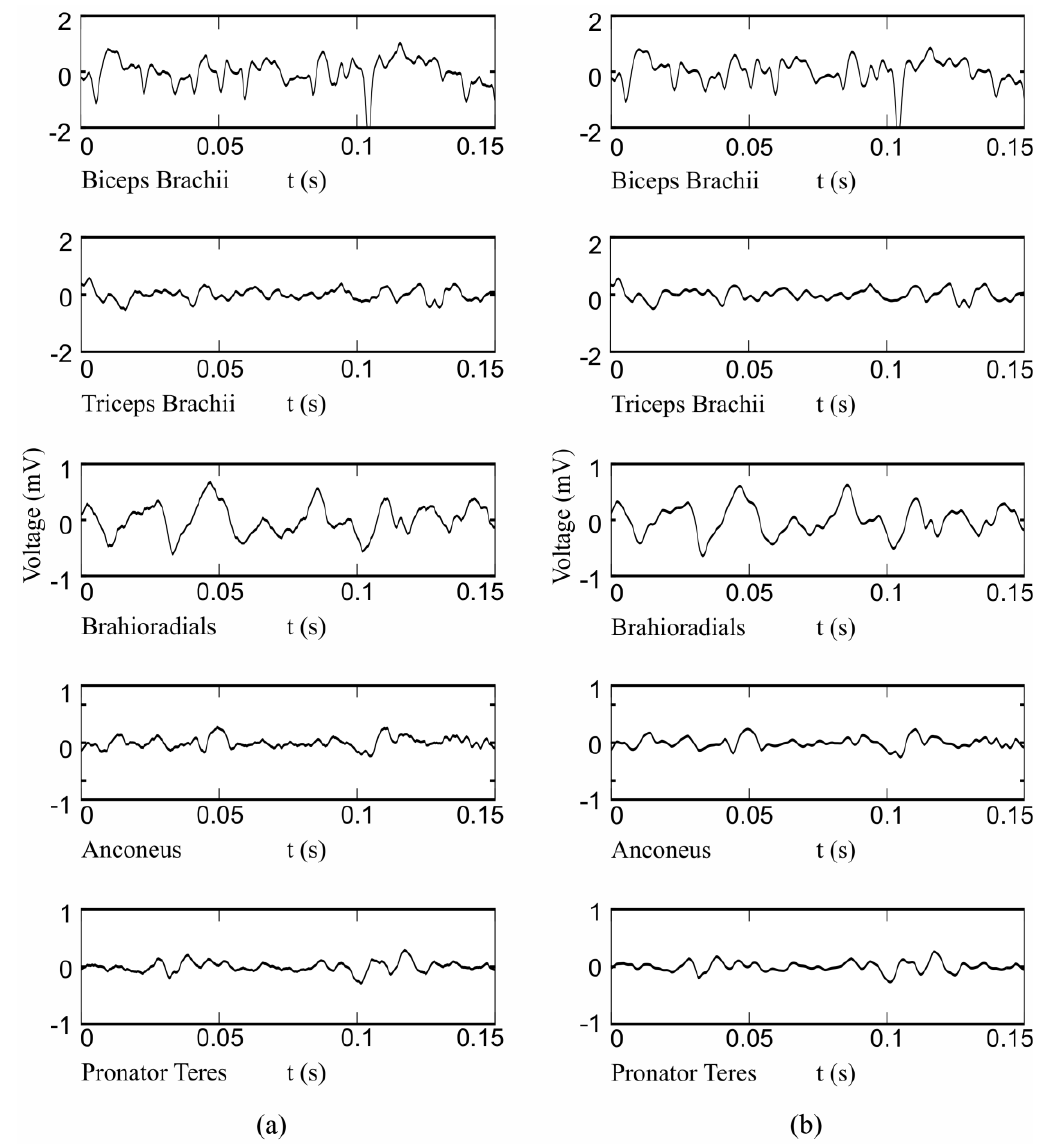
Figure B2. Examples of recorded EMG signals from five muscles (biceps brachii, triceps brachi, brachioradialis, anconeus, bracioradialis, and pronator teres) during flexion. Figure shows ( a ) raw signals and ( b ) signals filtered using 4th order Butterworth filter with the cut-off frequencies of 15 Hz and 350 Hz.